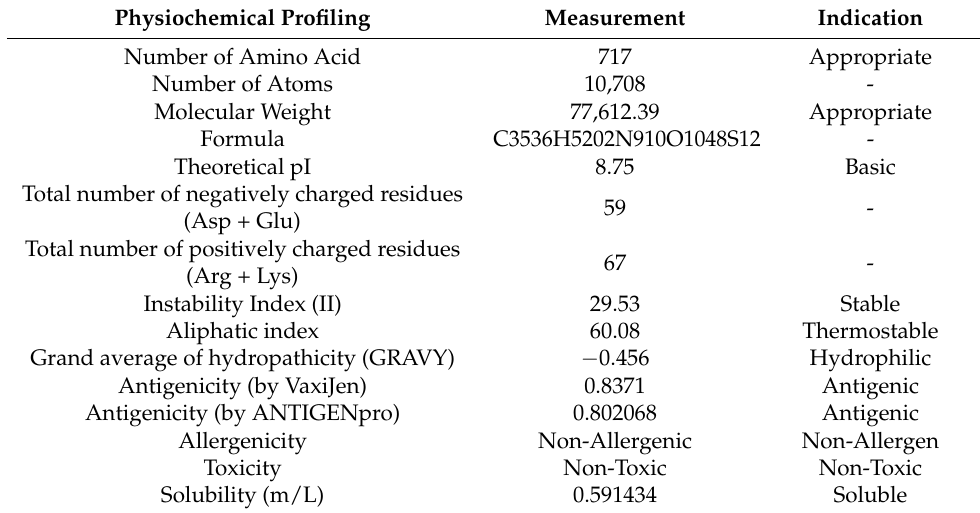
Table 5. Physiochemical profiling of the mRNA vaccine.